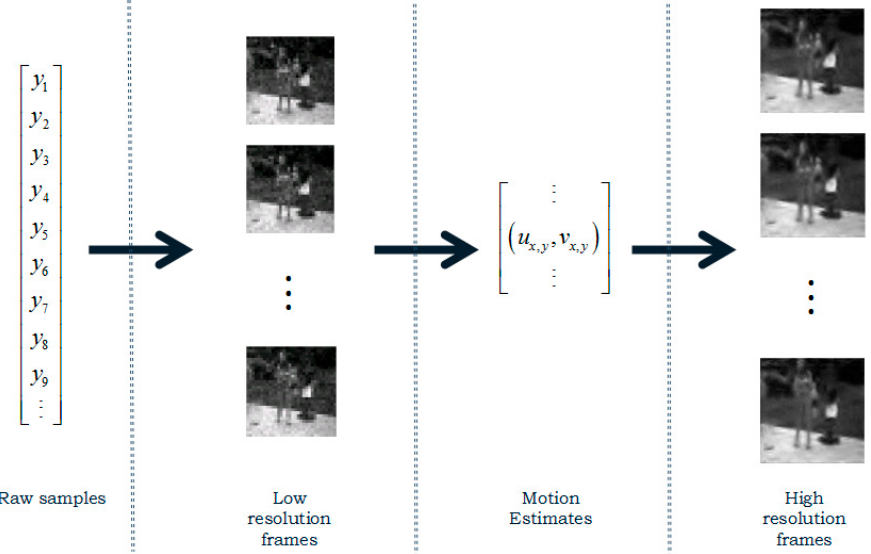
Figure 1. CS-MUVI Procedure.